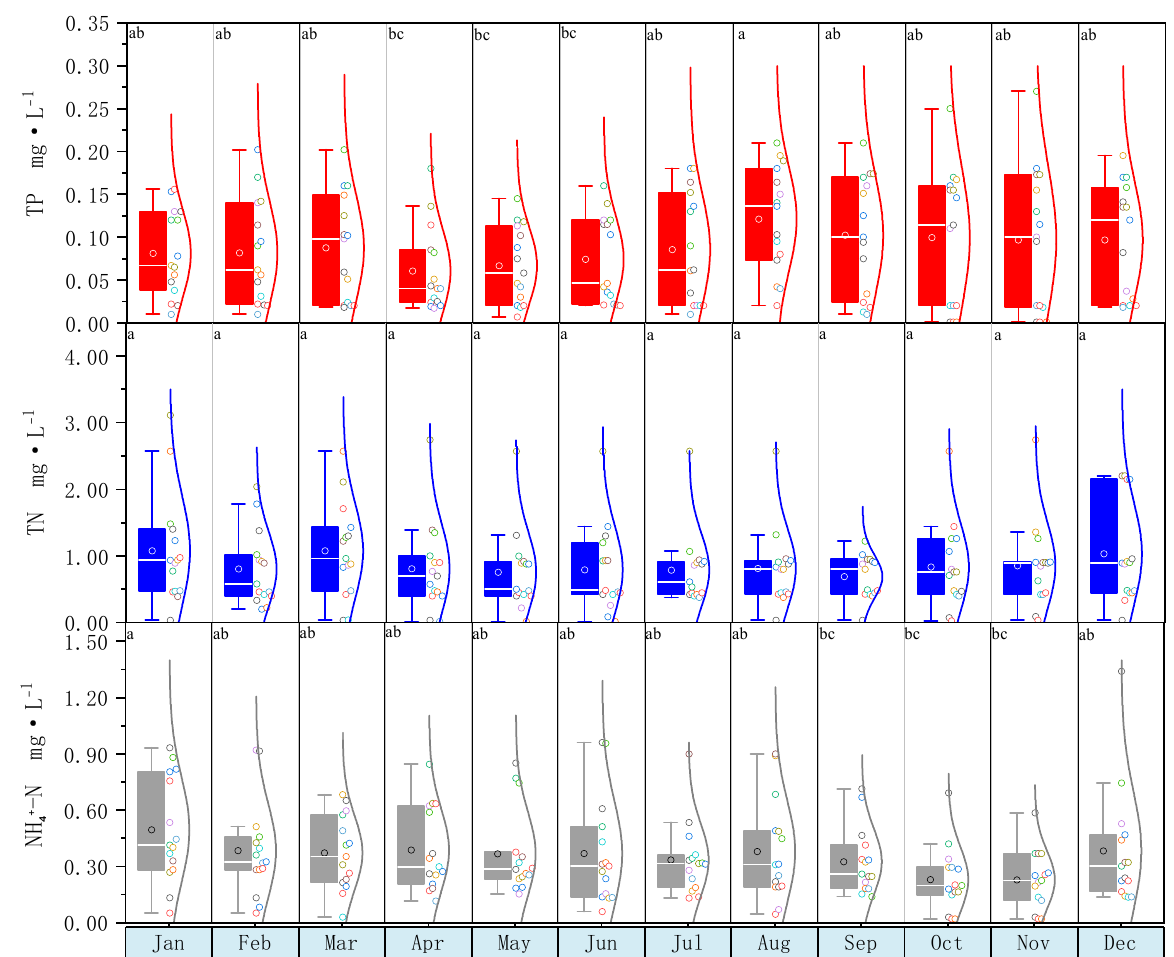
Figure 3. River Yi average monthly nutrient content for 2005–2019, different lowercase letters indicate significant differences between nutrients among different months at 0.05 significant level.